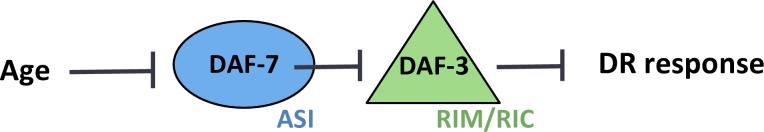
A decline in neuronal daf-7 expression with advancing age alters sensitivity to effects of DR on lifespan.Declines in daf-7 expression in ASI chemosensory neurons with age inhibit activity of daf-3 in RIM/RIC interneurons, the active form of which is able to interfere with the DR response in other tissues.